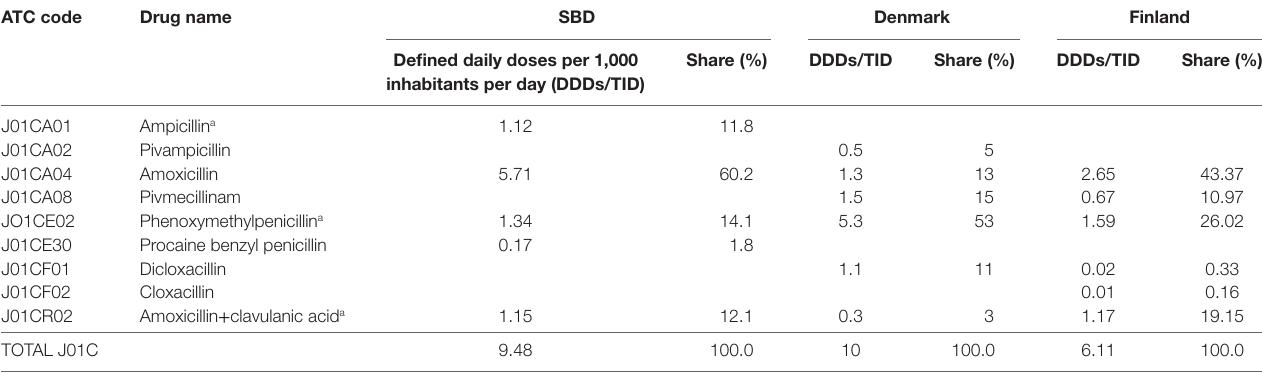
TaBle 2 | Utilization of antibiotics within penicillins subgroup (J01C) in South Backa District (SBD), Denmark, and Finland in 2008. aTc